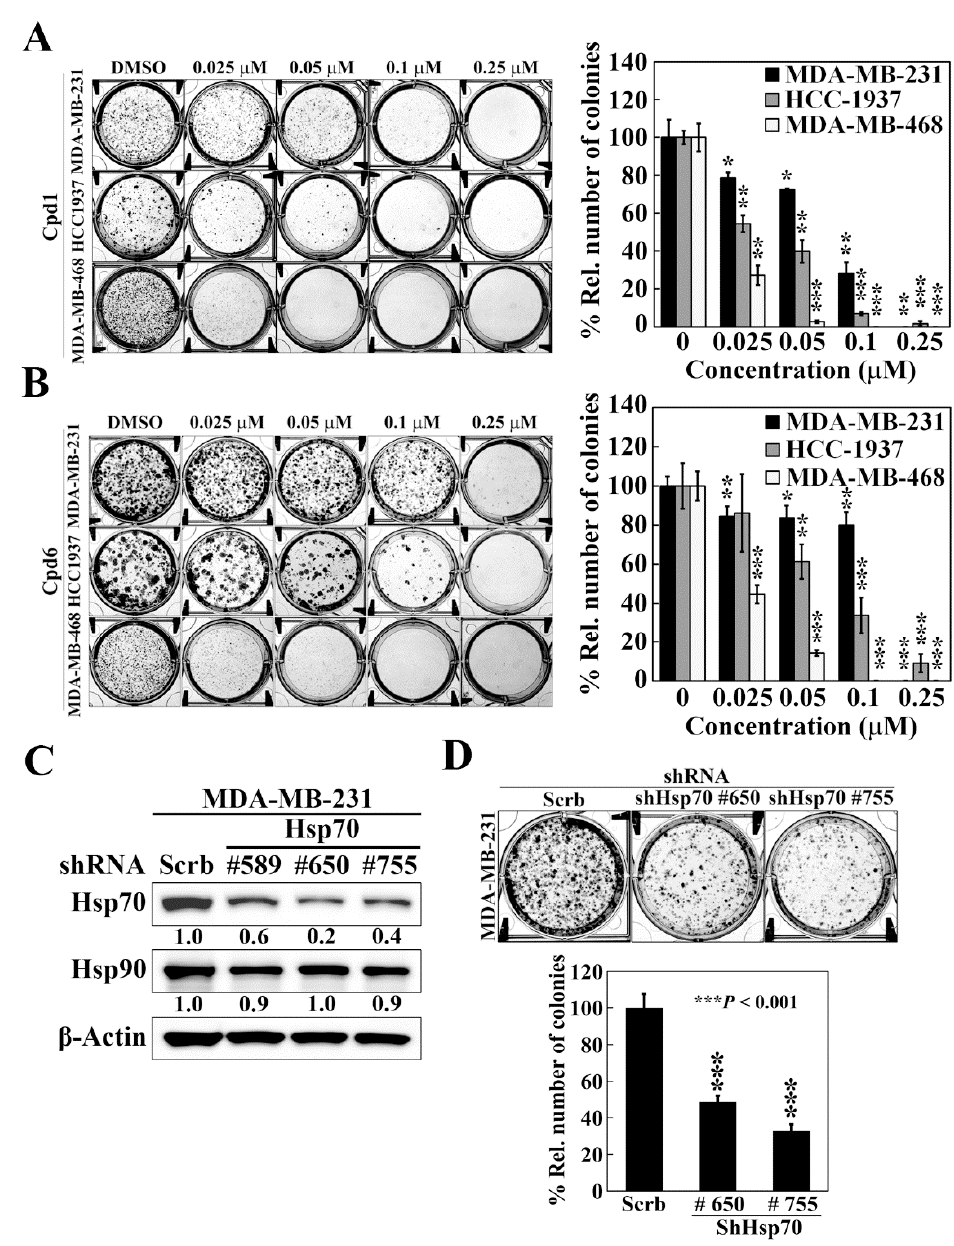
Figure 3. Effects of compound 1, compound 6, and Hsp70 knockdown on cell proliferation in triple negative breast cancer cells. ( A ) Left, representative images showing the effect of compound 1 on colony formation in MDA-MB-231, HCC-1937, and MDA-MB-468 cells. Right, quantitative results of colony formation expressed as the percentage compared with the DMSO control. Data, means ± S.D., * p < 0.05, ** p < 0.01, *** p < 0.001. ( B ) Left, representative images showing the effect of compound 6 on colony formation in MDA-MB-231, HCC-1937, and MDA-MB-468 cells. Right, quantitative results of colony formation expressed as the percentage compared with the DMSO control. Data, means ± S.D., * p < 0.05, ** p < 0.01, *** p < 0.001. ( C ) Western blot analyses of the effect of stable knockdown of Hsp70 on the expression of Hsp70 and Hsp90 in MDA-MB-231 cells. Values under Hsp70 and Hsp90 blots represent the relative expression compared to control shRNA. The band intensity was measured densitometrically using Image J software and normalized to the β -Actin band. ( D ) Upper, representative images showing the effect of stable knockdown of Hsp70 on colony formation in MDA-MB-231 cells. Lower, quantitative results of colony formation from stable knockdown of Hsp70 in MDA-MB-231 cells. Data, means ± S.D., *** p < 0.001.